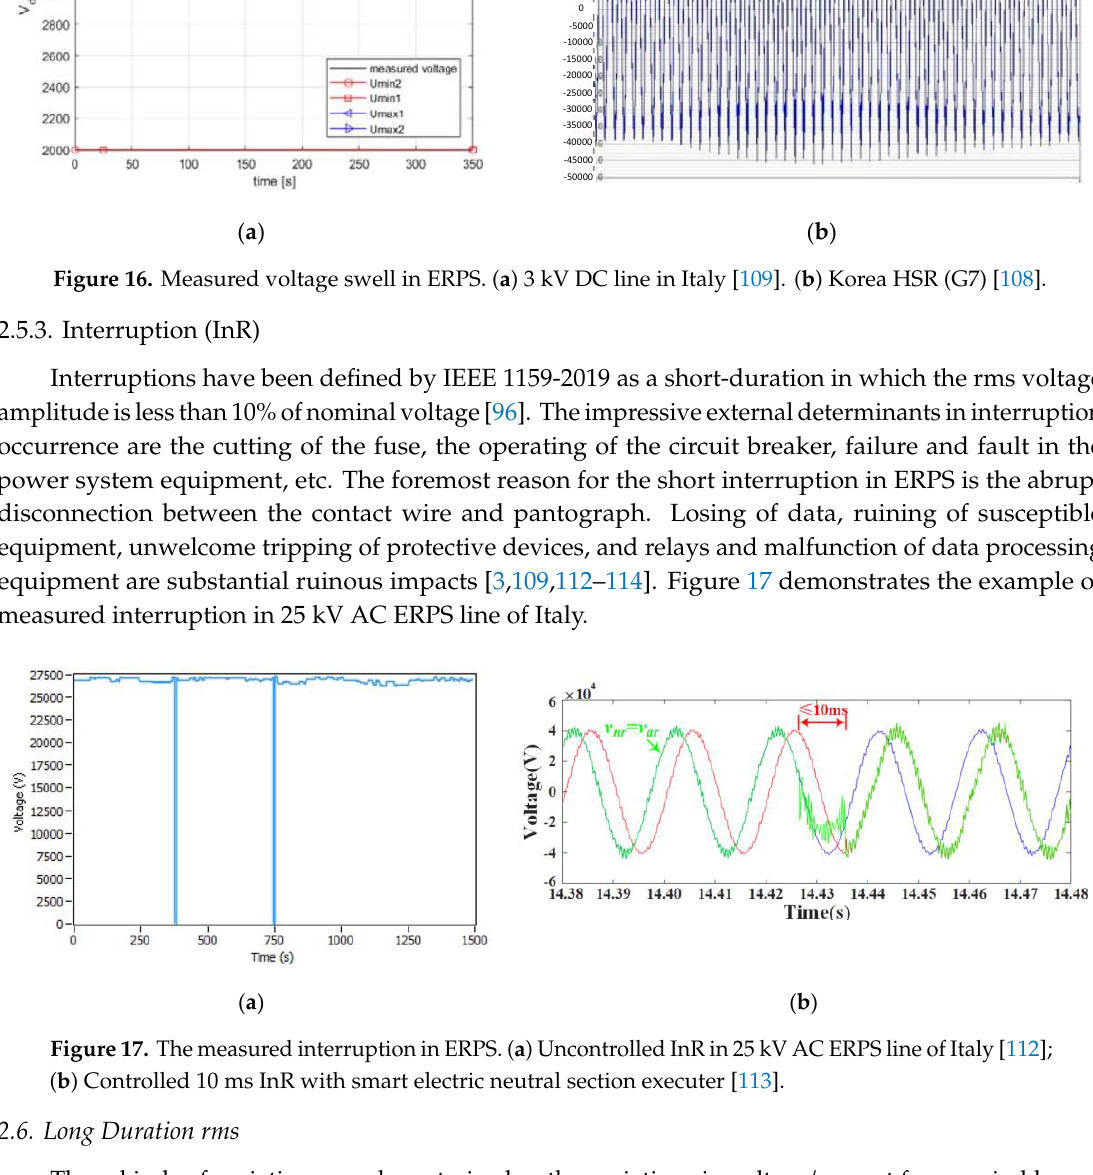
( b ) Controlled 10 ms InR with smart electric neutral section executer [112]; ( b ) Controlled 10 ms InR with smart electric neutral section executer [113].